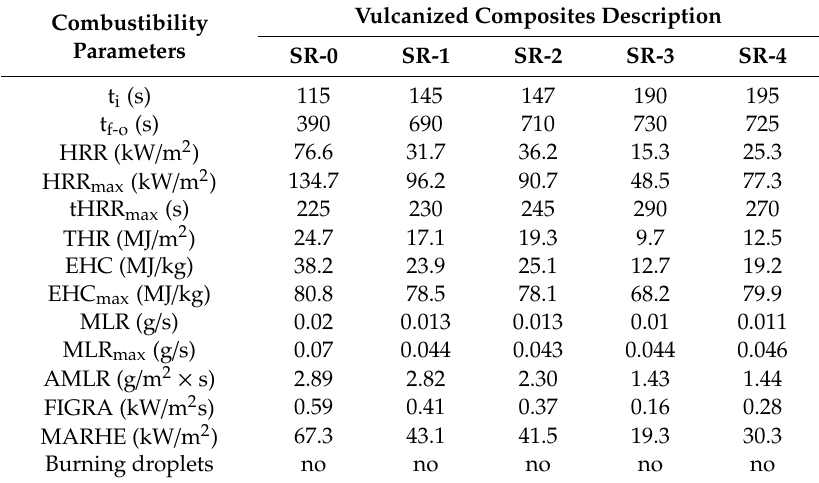
Table 5. Flammability of composites with BFL and